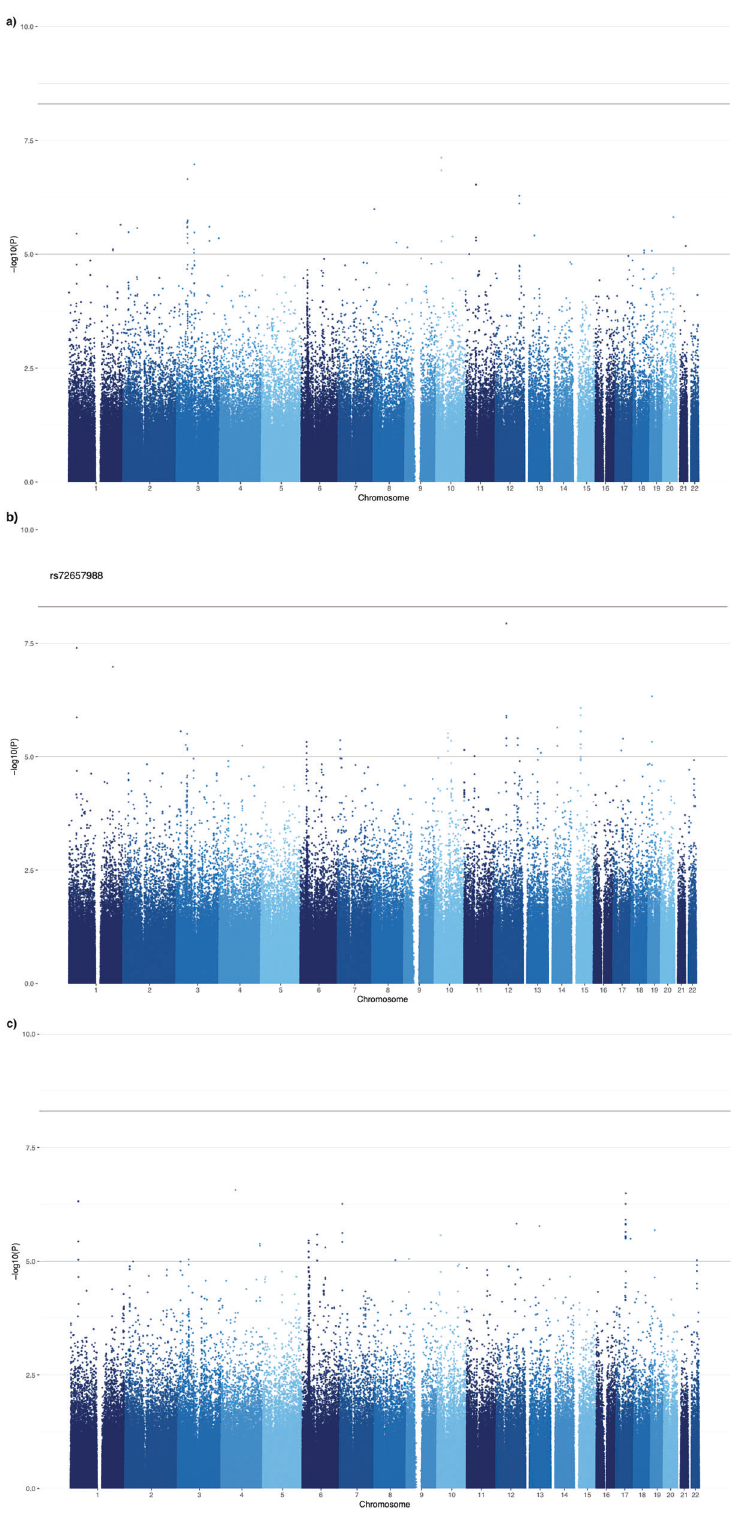
Fig. 2 Manhattan plot for single variants. Panels depict the – log 10 ( p -value) of association test statistics for single variants with a the internalising factor of depression (Int), b general factor of schizophrenia (Sch), and c general factor of bipolar disorder (Bip). Points on this plot represent individual genetic variants. The horizontal axis depicts the genomic coordinate of variants tested for an association with the internalising factor of depression. Minimum MAF = 0.05%. The solid horizontal line (at p = 5 x10 – 9 ) depicts the threshold for genome-wide statistically signi fi cant associations, while the light horizontal line (at p = 1 x 10 – 5 ) depicts a more lenient threshold above which variant rsID numbers are